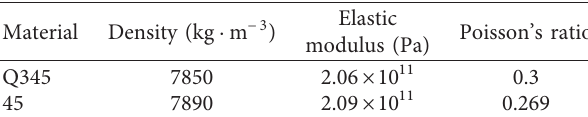
Figure 7: Simplified model of hydraulic support and meshing of tail beam and particles. Table 1: Main material properties of steels.